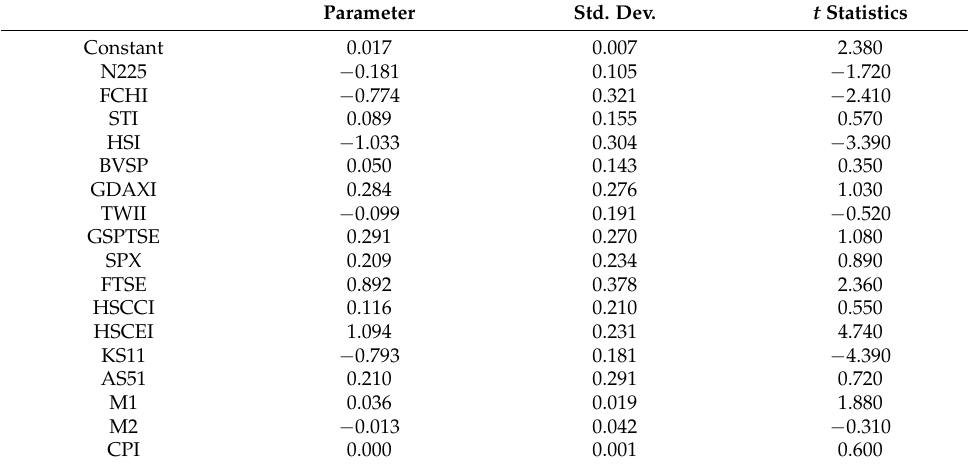
Table A1. Parameter estimates from OLS regression for counterfactual volatility.